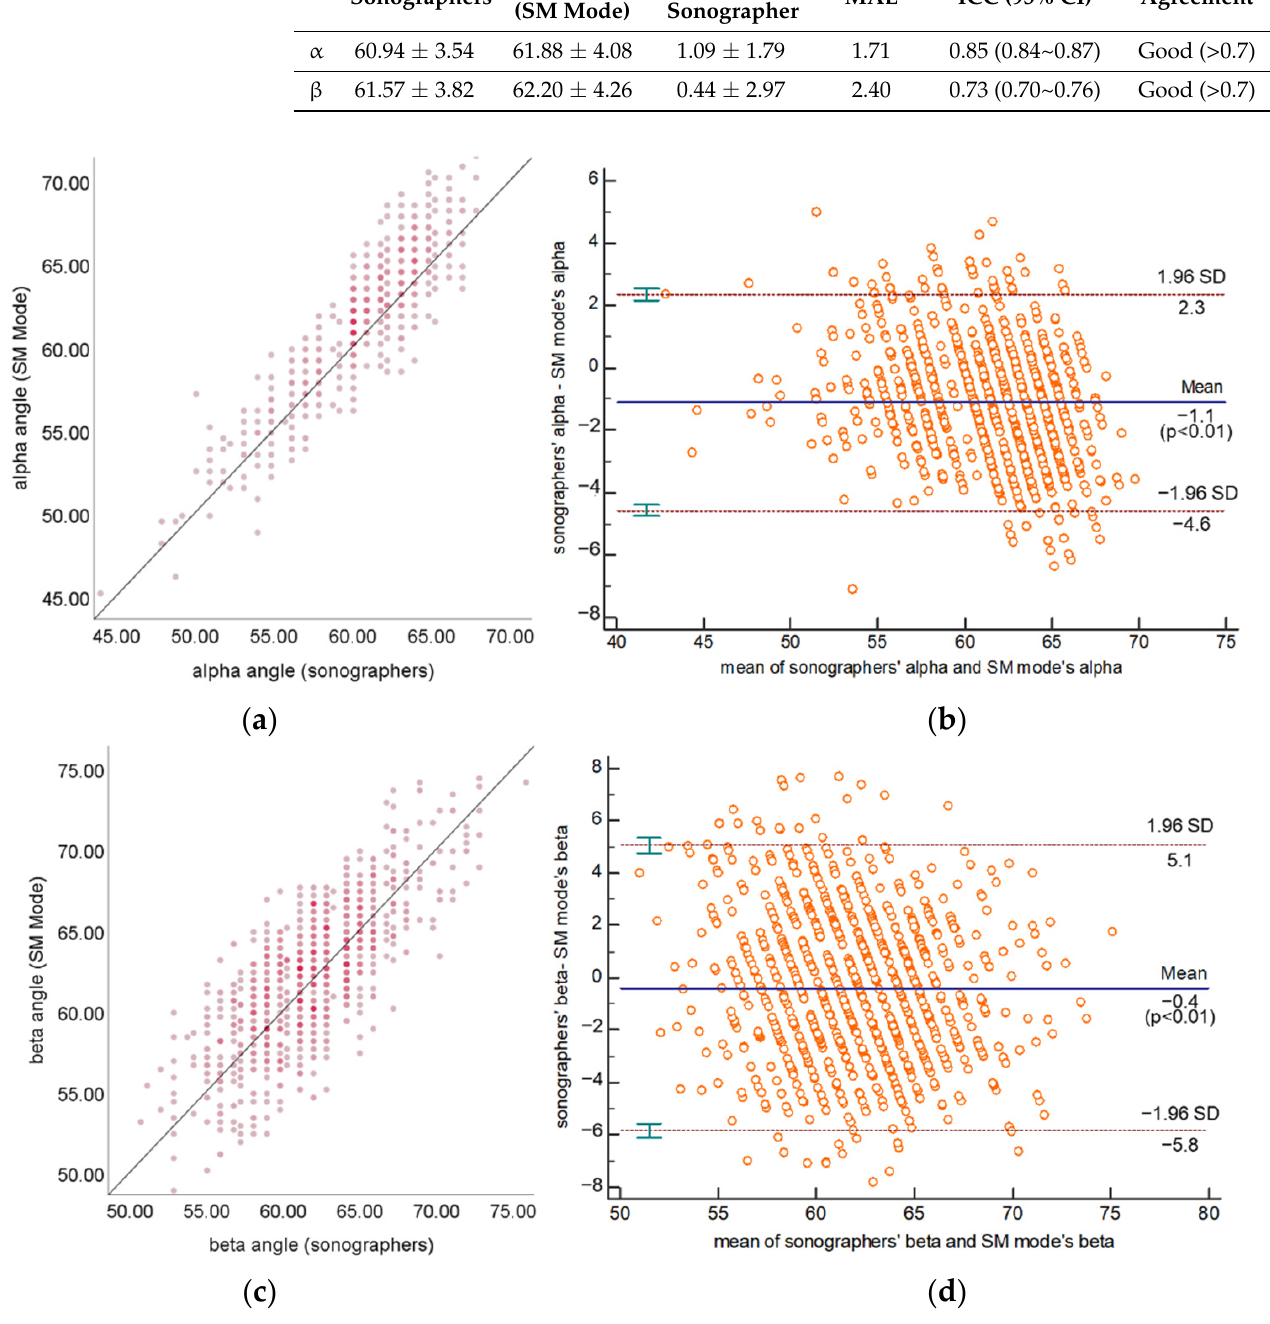
Figure 6. Scatter plots and Bland–Altman plots of α ( a , b ) and β ( c , d ) measured by SM mode and sonographers.